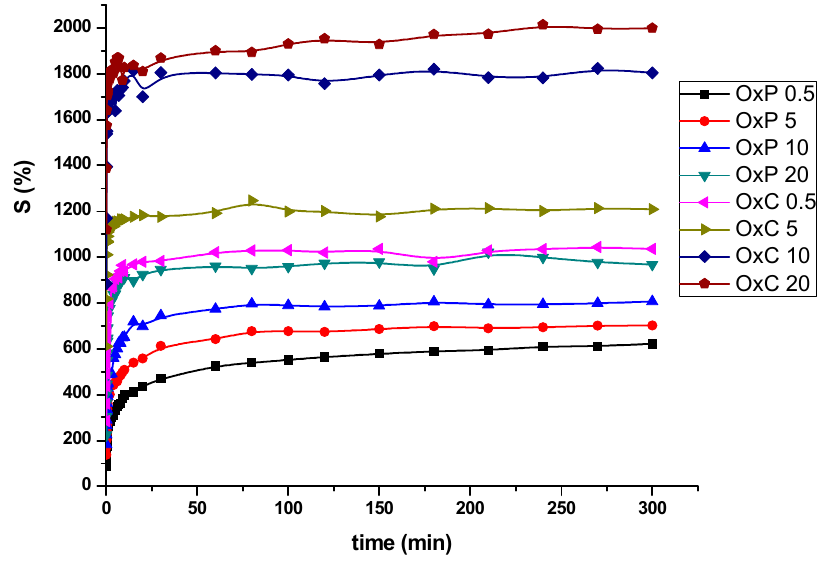
Figure 4. Swelling behavior of PVA hydrogels containing 0.5%, 5%, 10% and 20% oxidized pullulan (OxP 0.5, OxP 5, OxP 10, OxP 20) and tricarboxy cellulose (OxC 0.5, OxC 5, OxC 10, OxC 20), respectively.